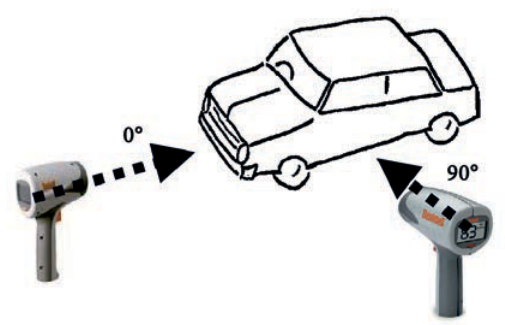
Fig. 3. Example of measurements at 0 or 90 degrees angles